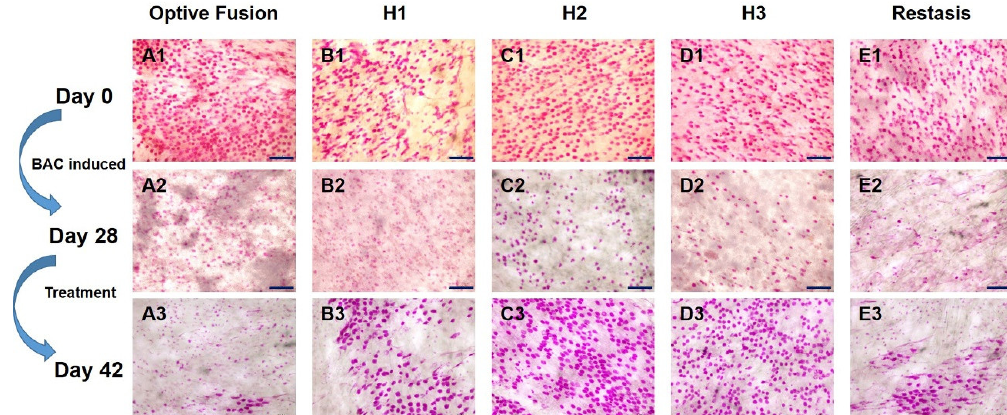
Figure 4. Representative images of PAS-stained conjunctival impression cytology images in BAC-treated eyes for each group on days 0 ( A1 – E1 ), day 28 ( A2 – E2 ), and day 42 ( A3 – E3 ). Goblet cell densities were increased, and the cell shape appeared normal in all treatment groups except for Optive Fusion ® . Scale bar = 100 μm.